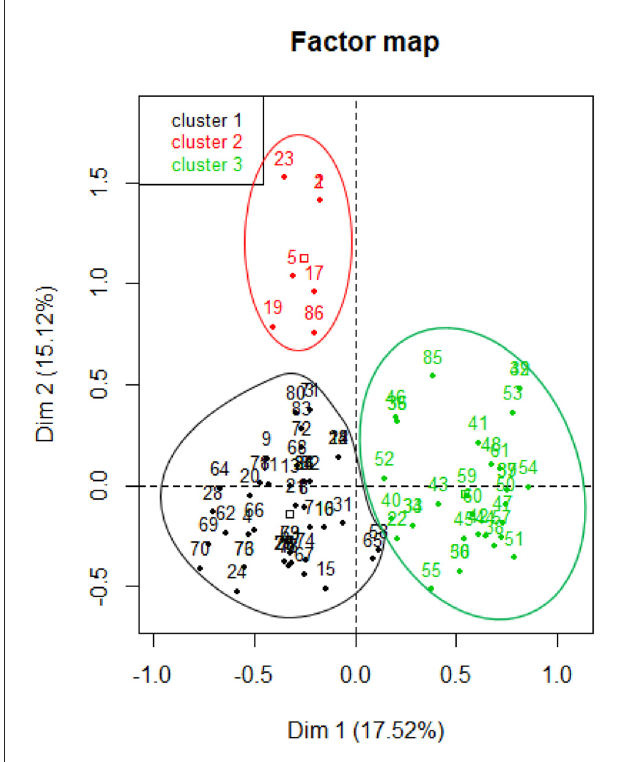
FIGURE5 Classification of Wagashi Gassirè consumers from Dassa-Zoumé and